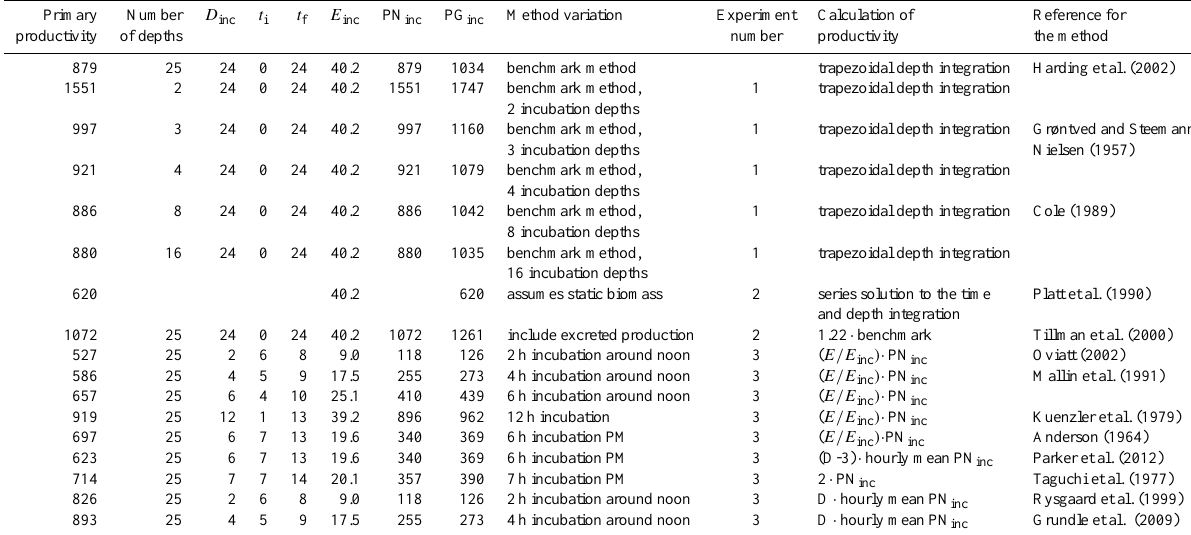
Fig. 7. Schematic showing the 24h diel cycle of incident photosynthetically active radiance (blue line, upper panel) beginning at sunrise ( t = 0), and depth distribution of PAR at solar noon (blue line, right panel) representative of summer conditions at a temperate latitude. The contour plot, lower left, shows the diel and vertical variability of hourly gross phytoplankton primary productivity (PG) based on equations, initial phytoplankton biomass and photosynthetic parameters described in the text. Horizontal arrows (upper panel) and filled circles (right panel) show incubation periods and depths prescribed to simulate outcomes of different protocols compared in Table 1. Table 1. Computed depth-integrated daily primary productivity (mgCm − 2 d − 1 ) of a common phytoplankton sample across a range of protocols. D is photoperiod and D inc is incubation duration (h); t i is start time of an incubation ( t 0 is sunrise); t f is end time; E is daily PAR and E inc is PAR during the incubation period (molquantam − 2 d − 1 ); PN inc is net production and PG inc is gross production during the incubation period (mgCm − 2